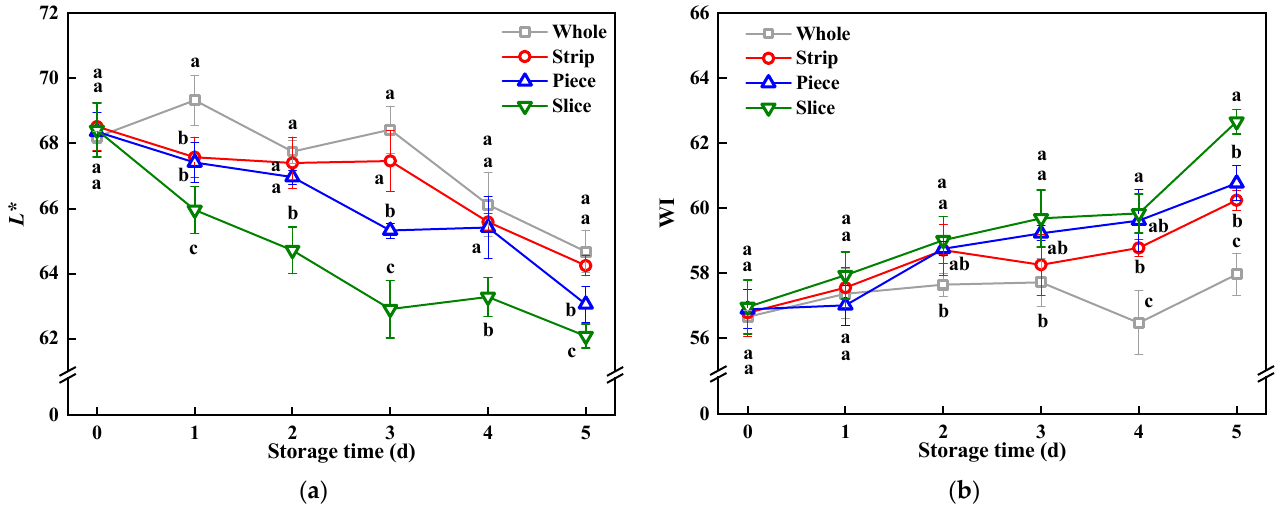
Figure 1. Effect of cutting methods on lightness ( L *) ( a ) and whiteness index (WI) ( b ) of fresh-cut cucumbers. Vertical bars represent the standard deviation of the mean (n = 3). Different letters indicate significant differences between the groups ( p < 0.05). Table 1. The effect of different cutting styles on the quality of fresh-cut cucumbers stored at 4 ◦